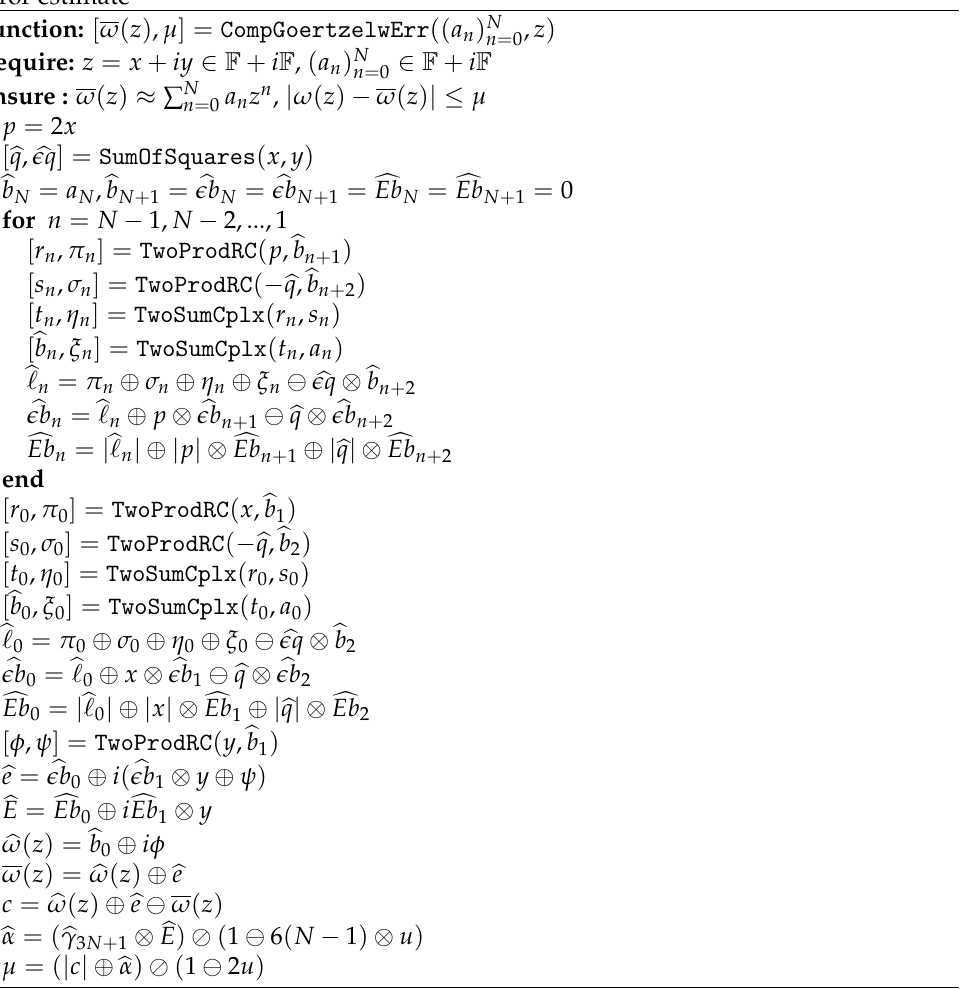
Algorithm 5 Polynomial evaluation by compensated Goertzel algorithm with a dynamic error estimate